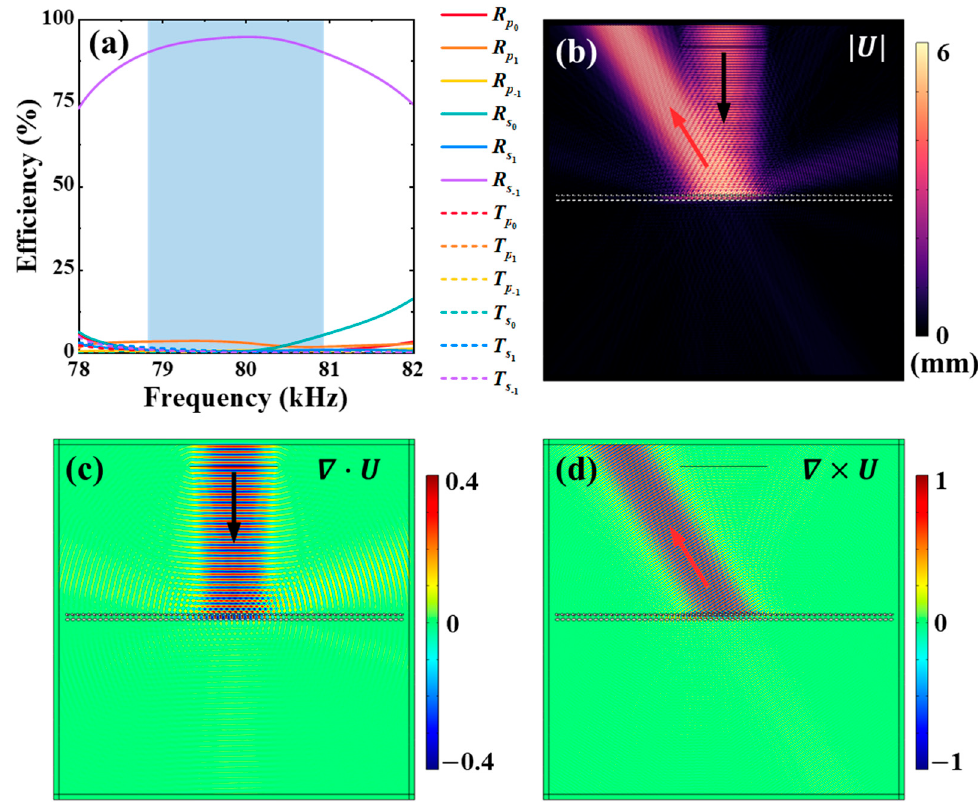
Figure 6. Mode conversion functionality of the metagrating, where a normally incident p -wave is completely and exclusively converted into a reflected s -wave along the R s channel. ( a ) The diffraction efficiency spectra for all 12 channels, where f 0 = 80 kHz is the operating frequency; ( b ) shows the amplitude of displacement amplitude at f 0 ; ( c , d ) show the divergence and curl of the displacement field, corresponding to longitudinal and transverse wave components, respectively. Black and red arrows represent the incident p -wave and reflected s -wave, respectively.